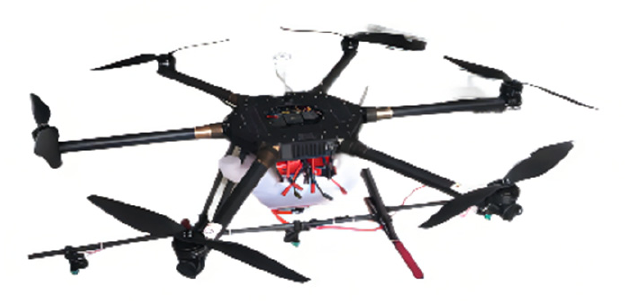
Figure 2. Harvest-1 plant protection UAV. The main performance parameters of the UAV are shown in Table 1. Three VP110-015 fan-shaped nozzles were mounted directly 0.5 m below the left and right rotors and the fuselage. At 0.5 MPa operating pressure, the spray flow rate of a nozzle was 0.013 kg/s. The Figure 2 . Harvest-1 plant protection UAV. diameter median, D 50 , at 0.3 m below the nozzle was about 86.38 µ m, whereas the mean